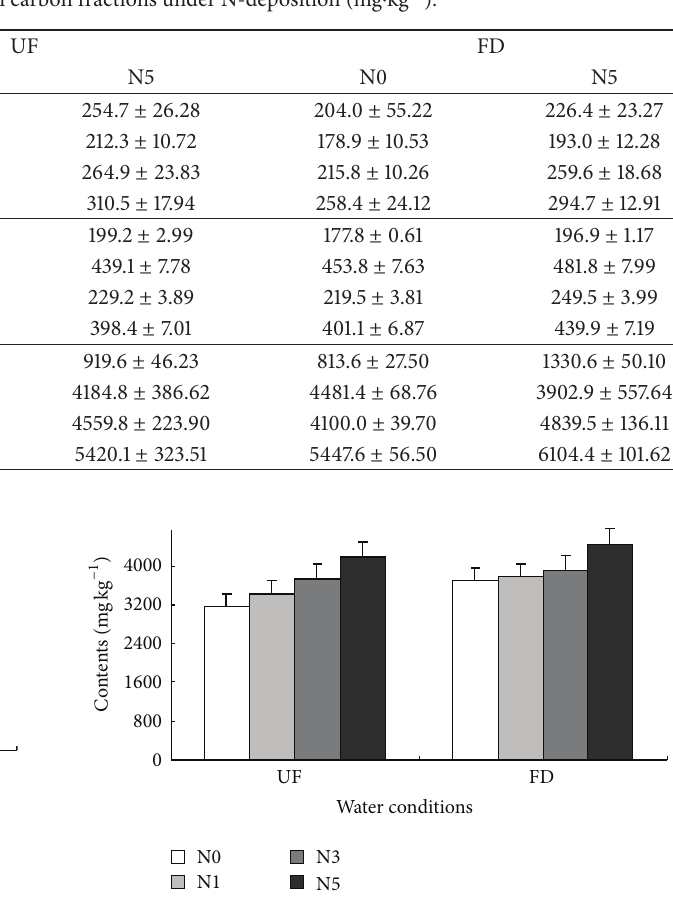
Figure 3: Effects of N-deposition on the wetland soil MBC.